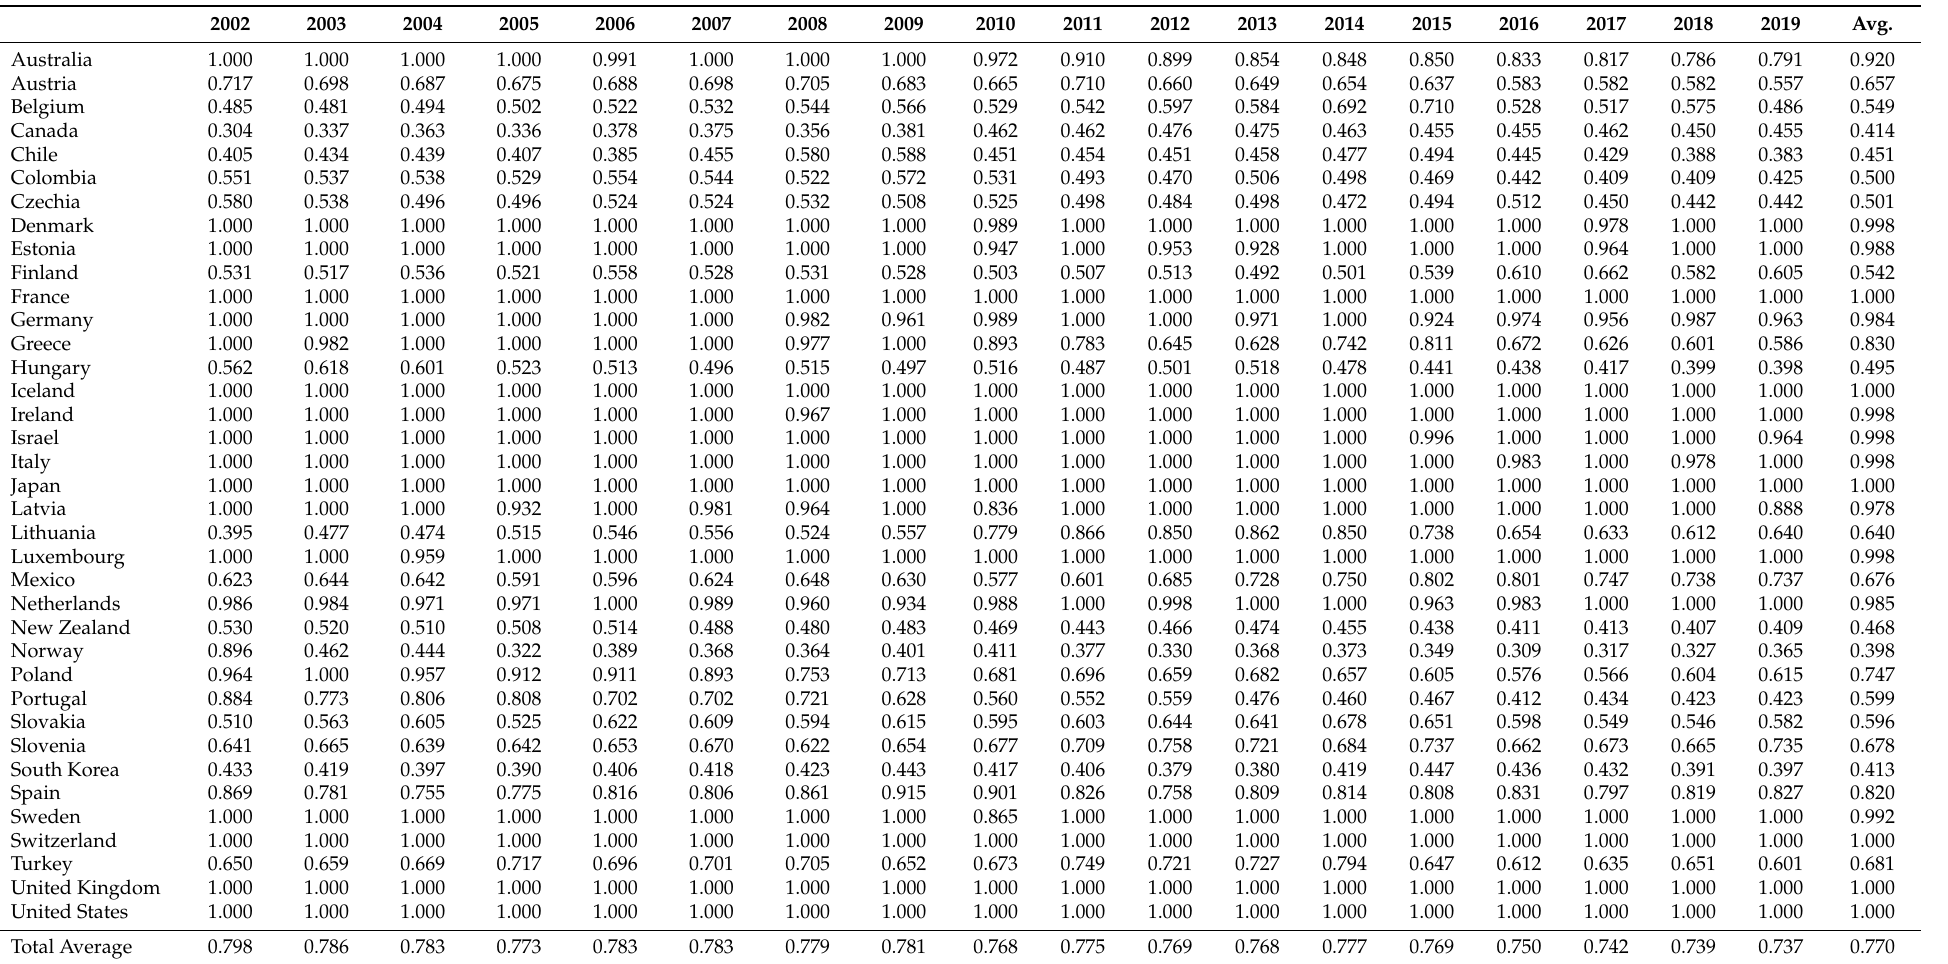
Table 7. Ratio between optimal and original EI (REI) scores among OECD nations: Zero-carbon-emission